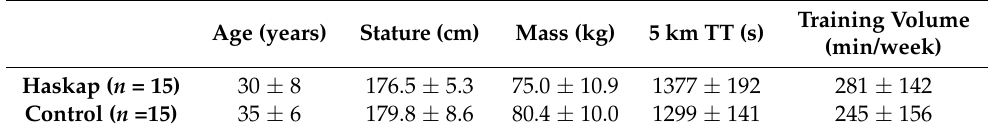
Table 1. Participant characteristics for the Haskap and Control groups.